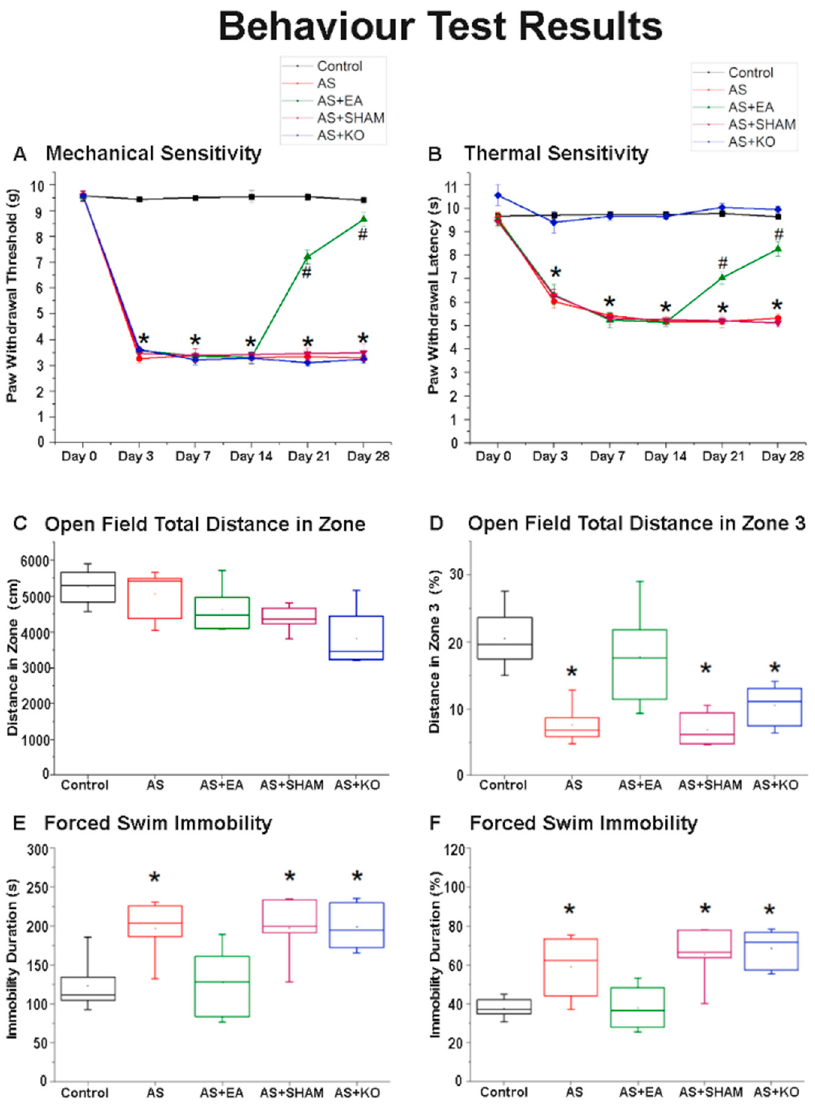
Figure 1. Comparative graph of paw withdrawal threshold and latency of the Acid-Saline (AS)- induced chronic pain subjects after electroacupuncture (EA) treatment and transient receptor vanilloid member 1 (TRPV1) gene deletion (KO). Control, AS, AS + EA, AS + SHAM, and AS + KO were tested according to ( A ) mechanical von Frey and ( B ) thermal Hargreaves’ nociceptive sensitivities. * p < 0.05 means when compared with the baseline of control group. # p < 0.05 means when compared with the AS and AS + SHAM groups. ( C , D ) Open Field testing and ( E , F ) Forced Swimming testing to depict depressive-like behavior. * p < 0.05 means when compared with the baseline of control group n = 6 for five groups.